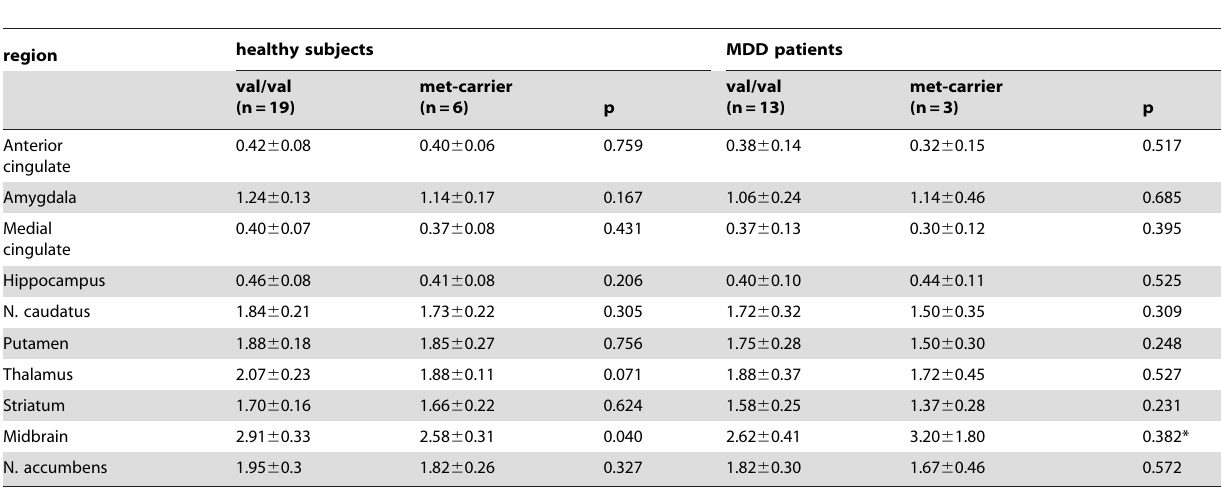
Table 3. Post-hoc t-tests comparing serotonin transporter (5-HTT) binding potential (BP ND ) according to BDNF Val66Met genotype status in 25 healthy subjects and 16 depressed